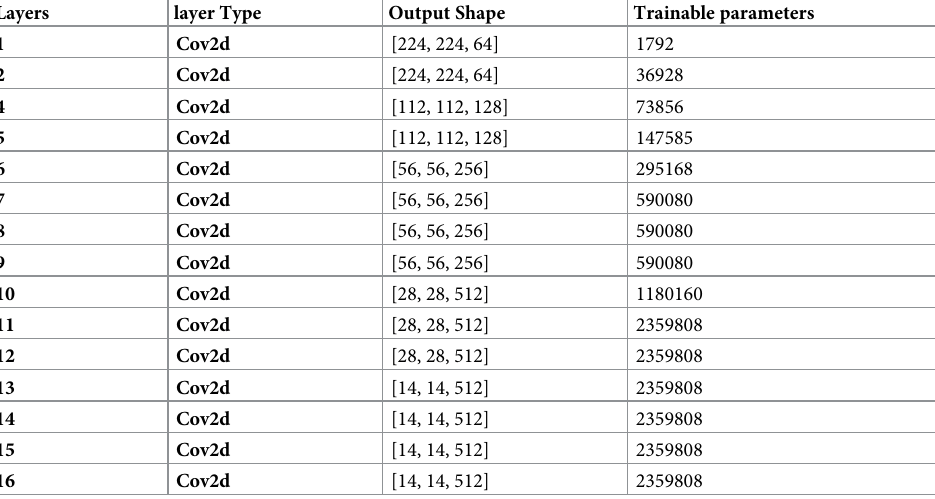
fier. The general structure and parameters of VGG16, which yielded high-performance accu- racy in chest x-ray images, are presented in Table 2 and hyper parameters are presented in Table 3. in their paper. The inception module aims to serve as a “multi-level function extractor” by Table 2. The layers and layer parameters of the VGG16 model.